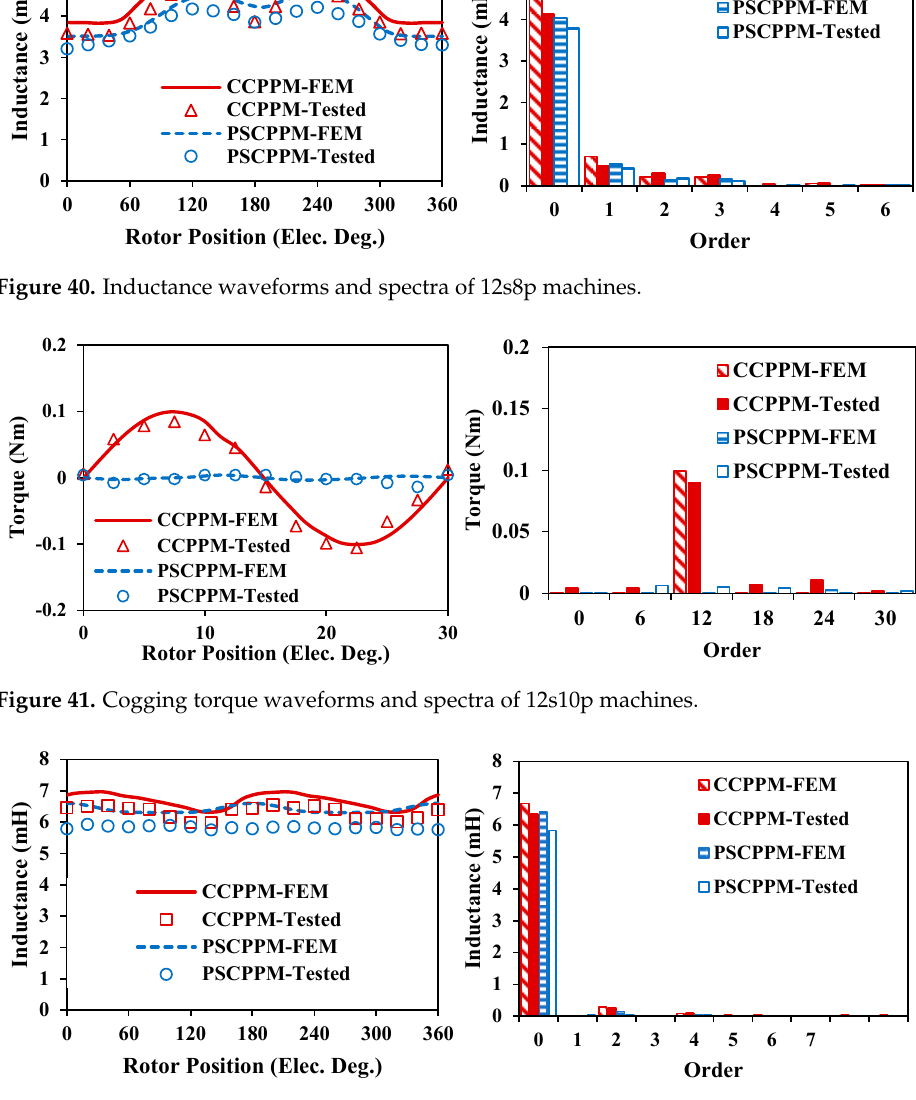
Figure 42. Inductance waveforms and spectra of 12s10p machines.